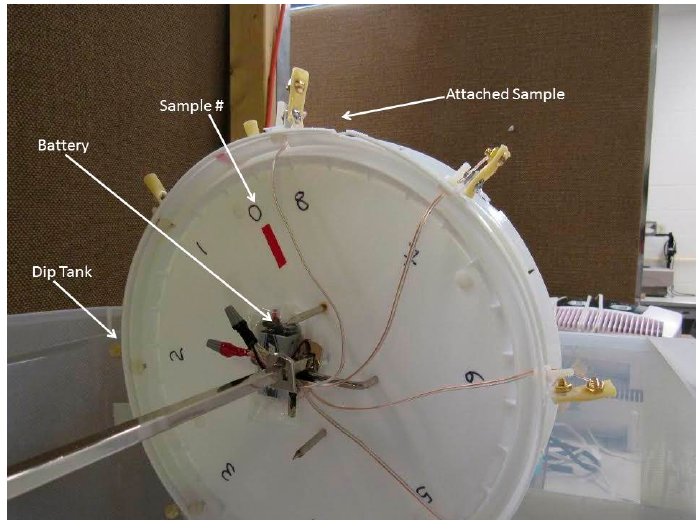
Figure 8. Rotation Disk Reactor with attached samples and dip tank.